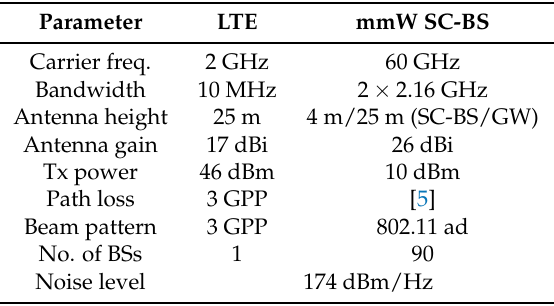
Table 1. Simulation